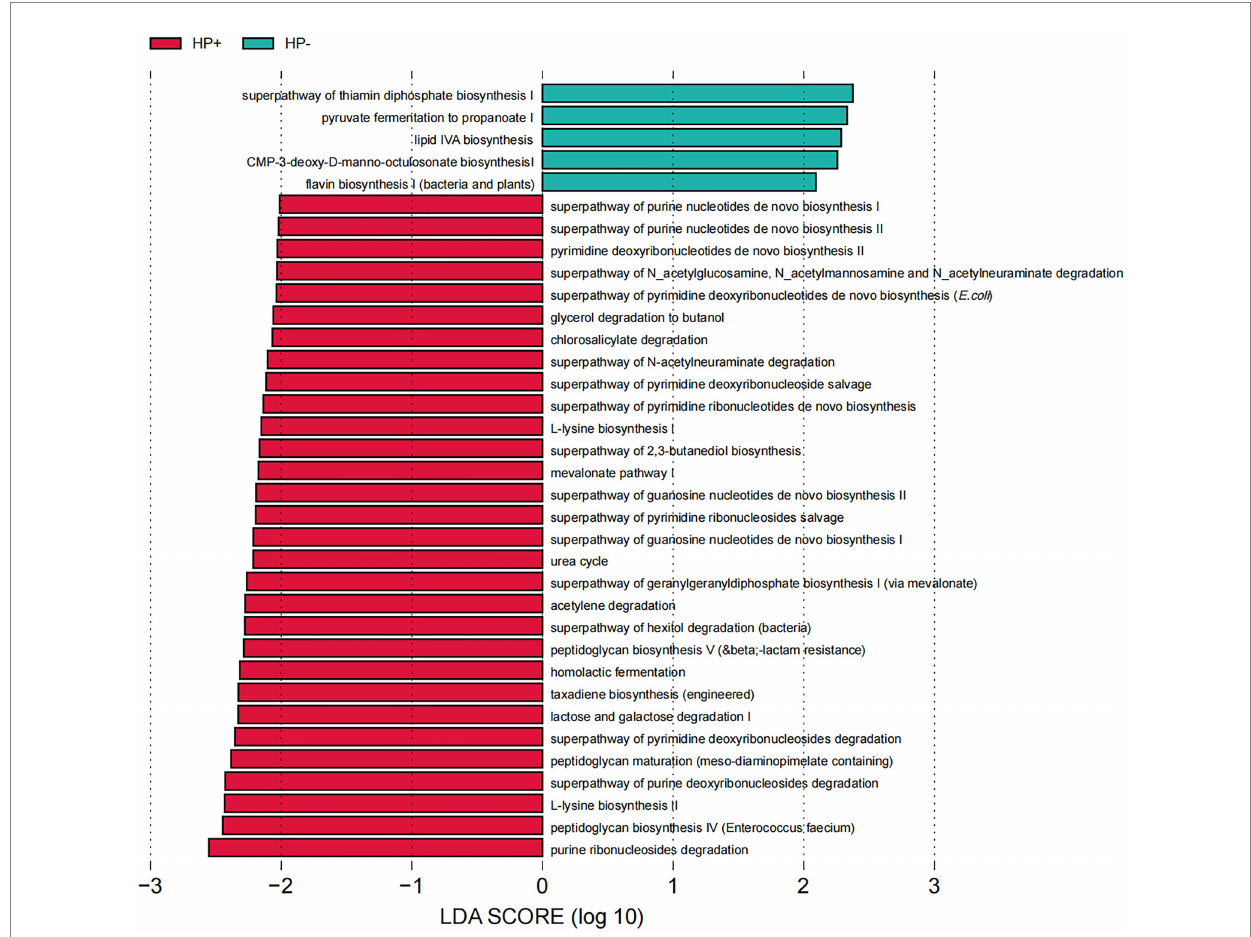
FIGURE 6 LEfSe analysis of GJM KEGG pathways differentially enriched in HP − and HP+